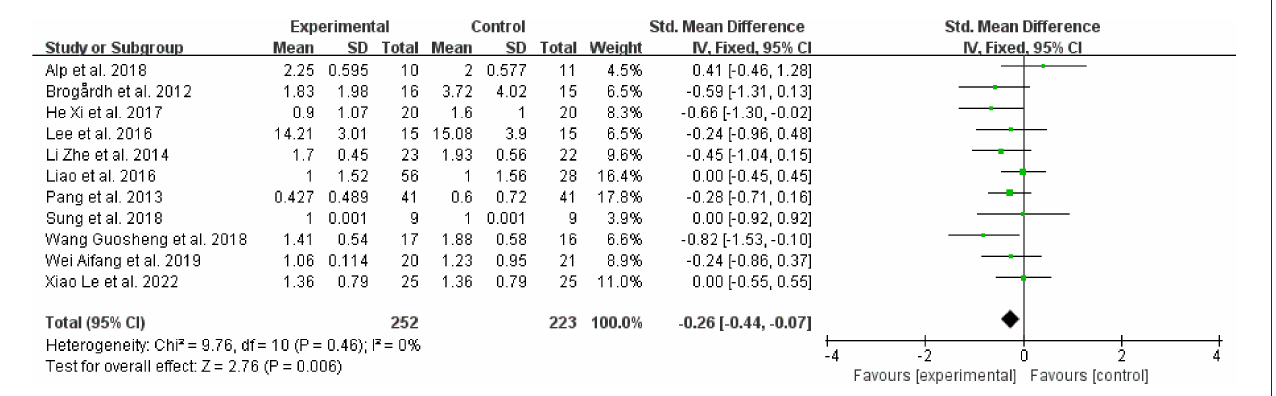
FIGURE5 Forest plot analysis of the efficacy of WBV on spasticity compared with control.